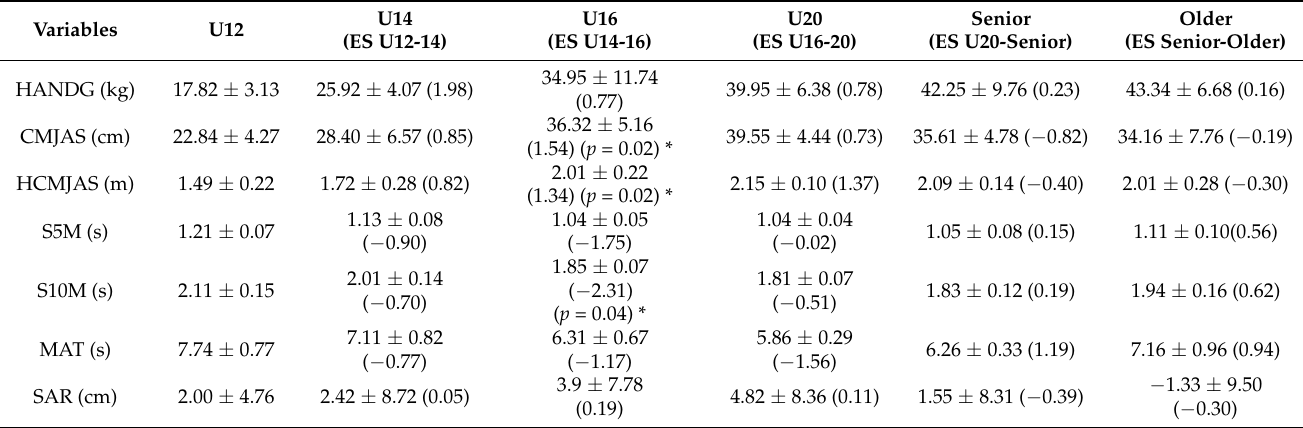
HANDG = handgrip isometric strength; CMJAS = vertical countermovement jump with arm swing; HCMJAS = horizontal countermove- ment jump with arm swing; S5M = 5 m sprint; S10M = 10 m sprint; MAT = modified agility test; SAR = flexibility sit and reach test;